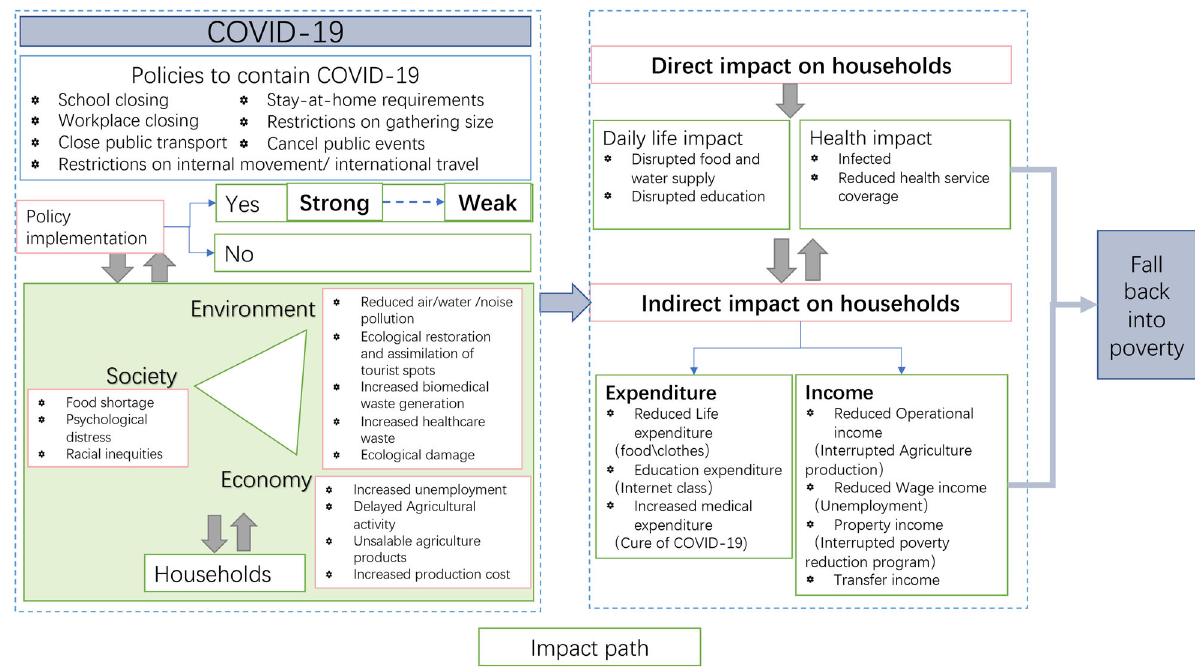
Fig. 1 The impact path of COVID-19 on poverty. There are two paths by which those who have been lifted out of poverty could fall back into poverty, which are direct impacts and indirect